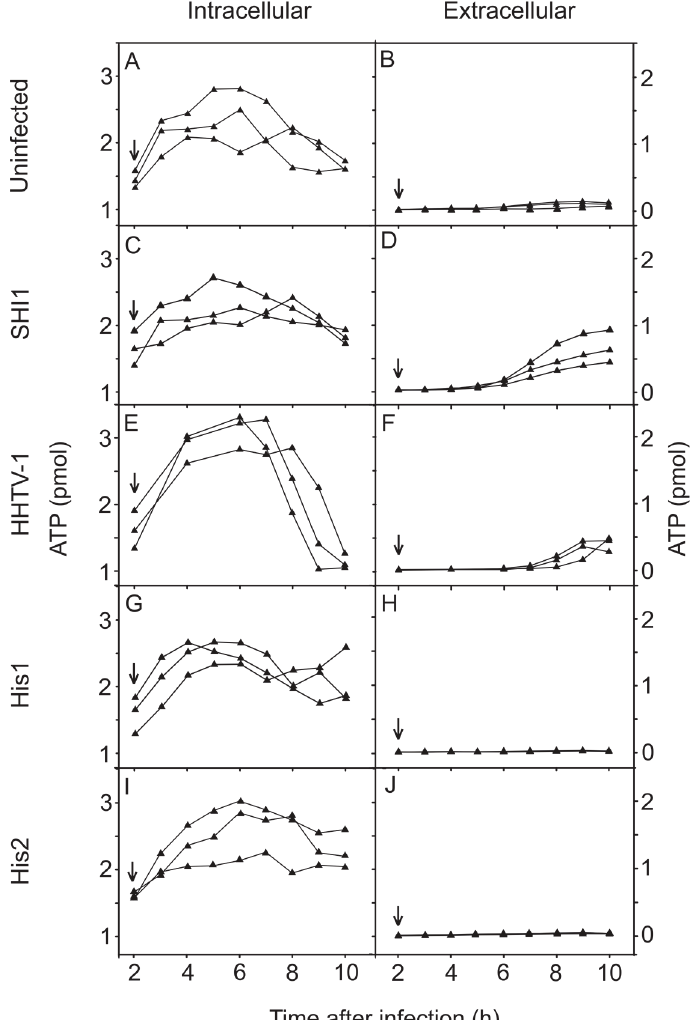
Figure 4. The amount of the intracellular and extracellular ATP in uninfected and virus-infected (MOI of 20) cultures. Unadsorbed viruses were removed at 2 h p.i. and measurements ( n = 3) were started at 2 h 15 min p.i. (marked by arrows).